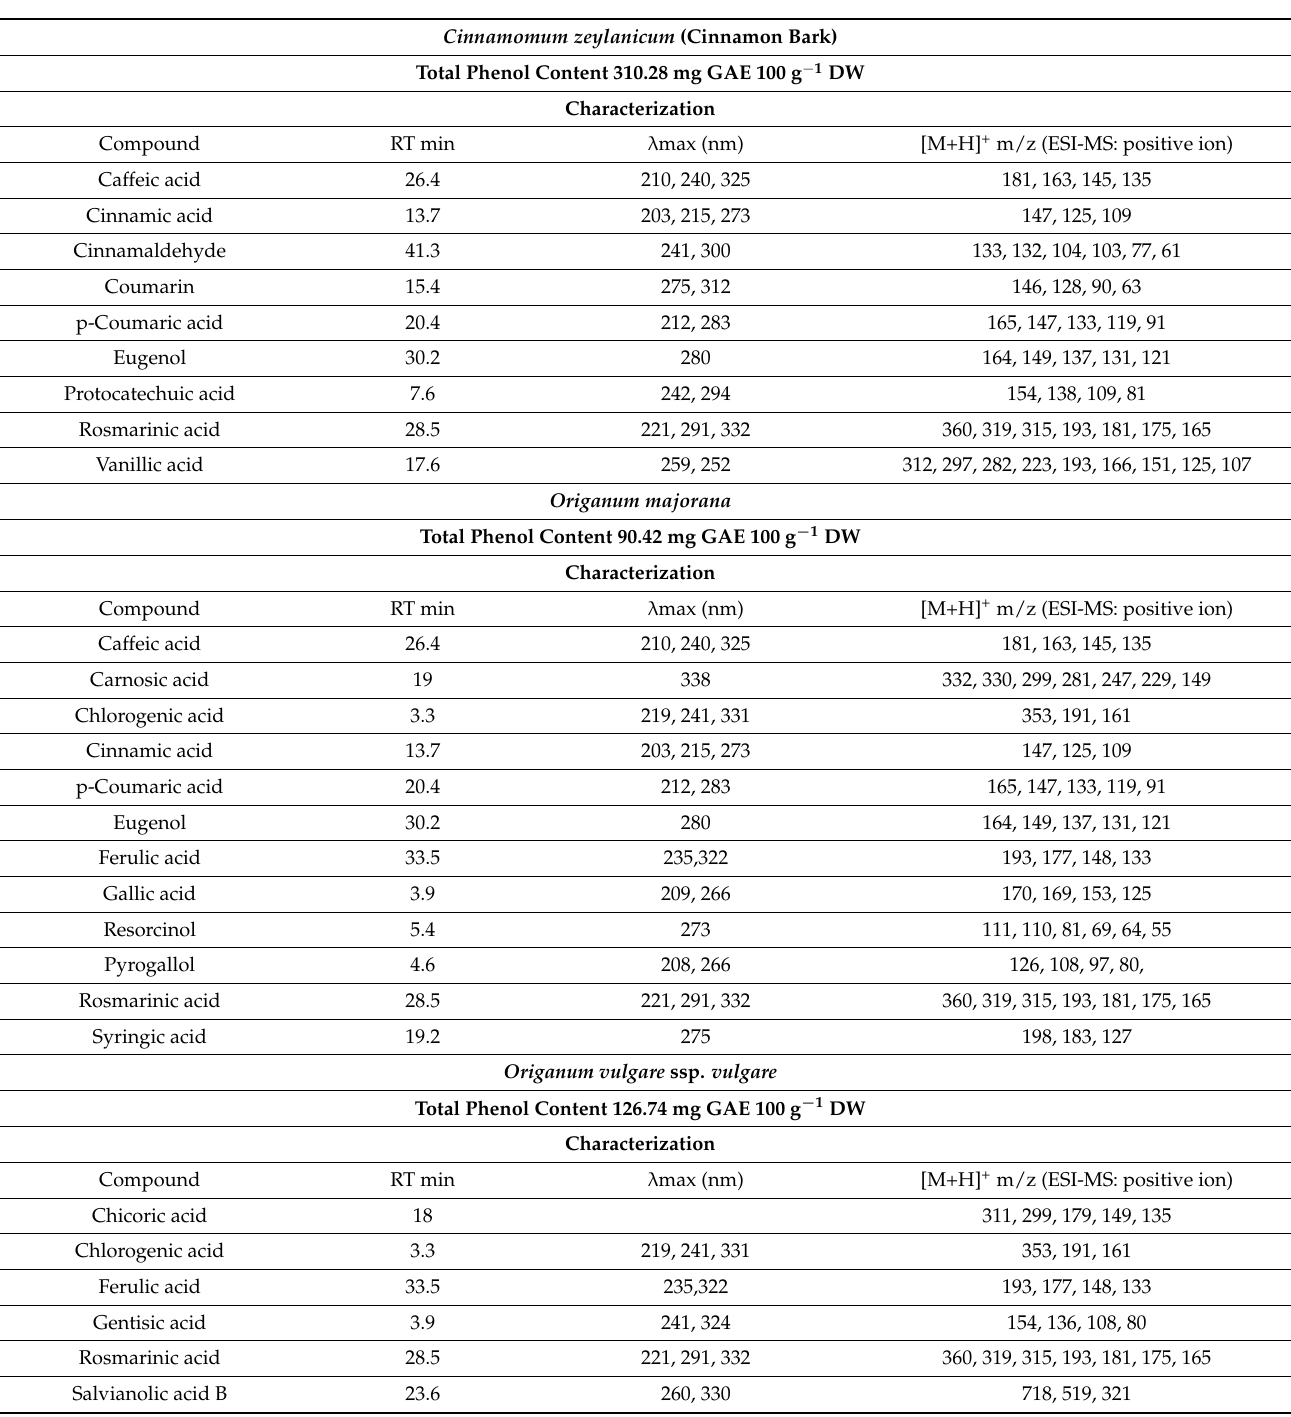
Table 1. Identification and characterization of the polyphenols from Cinnamomum zeylanicum, Orig- anum majorana , and Origanum vulgare ssp.